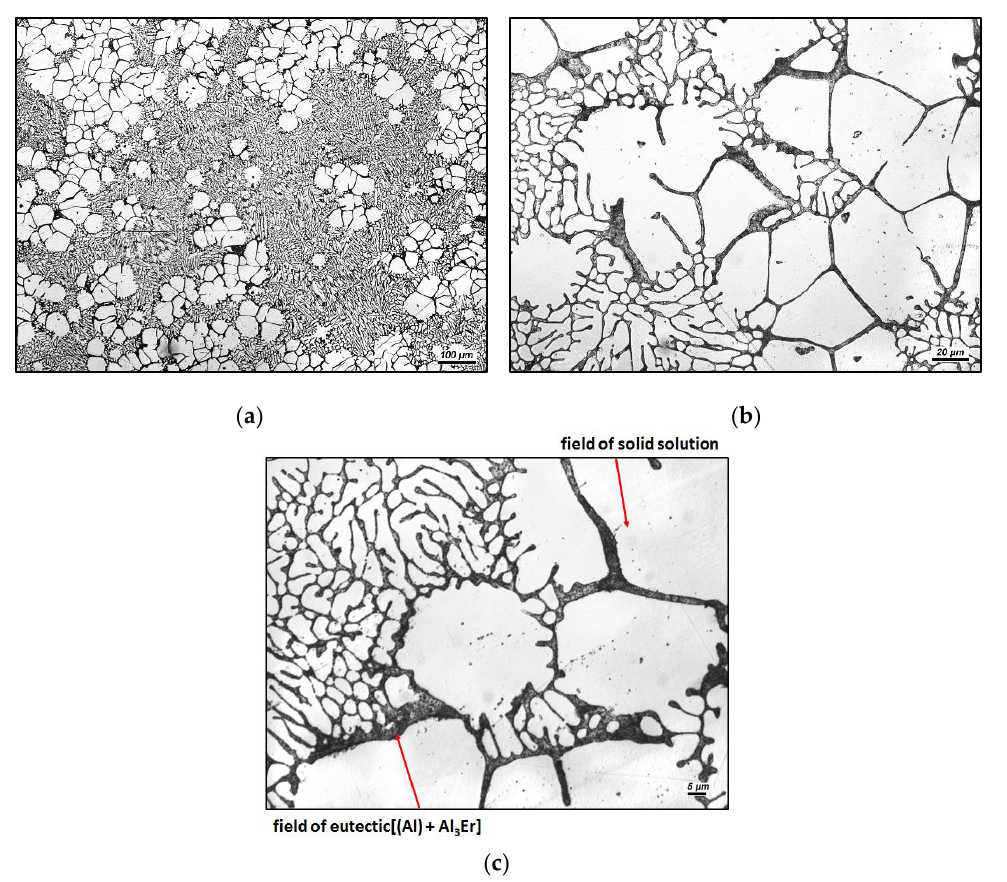
Figure 4. Microstructure of the master alloy composition Al–4.2Er with a high cooling rate: ( a ) ×100; ( b ) ×500; ( с ) ×1000. The electronic pictures of the microstructure and the EDX results of master alloys cast with a high cooling rate are shown in Figure 5. The spectrums are shown in Table 2.